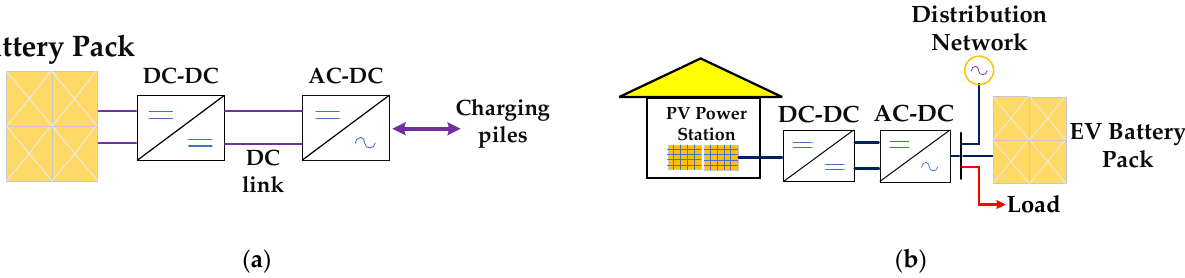
Figure 2. ( a ) Working schematic diagram of EV; ( b ) Schematic diagram of PV system impact mitigation by EVs.